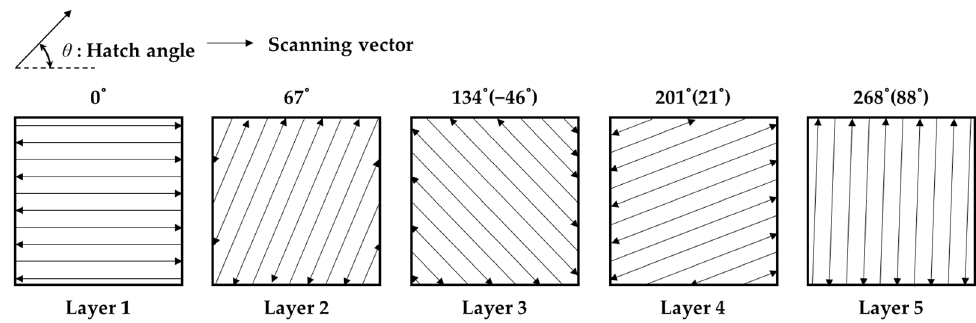
Figure 2. Schematic of the layer’s local coordinate system.